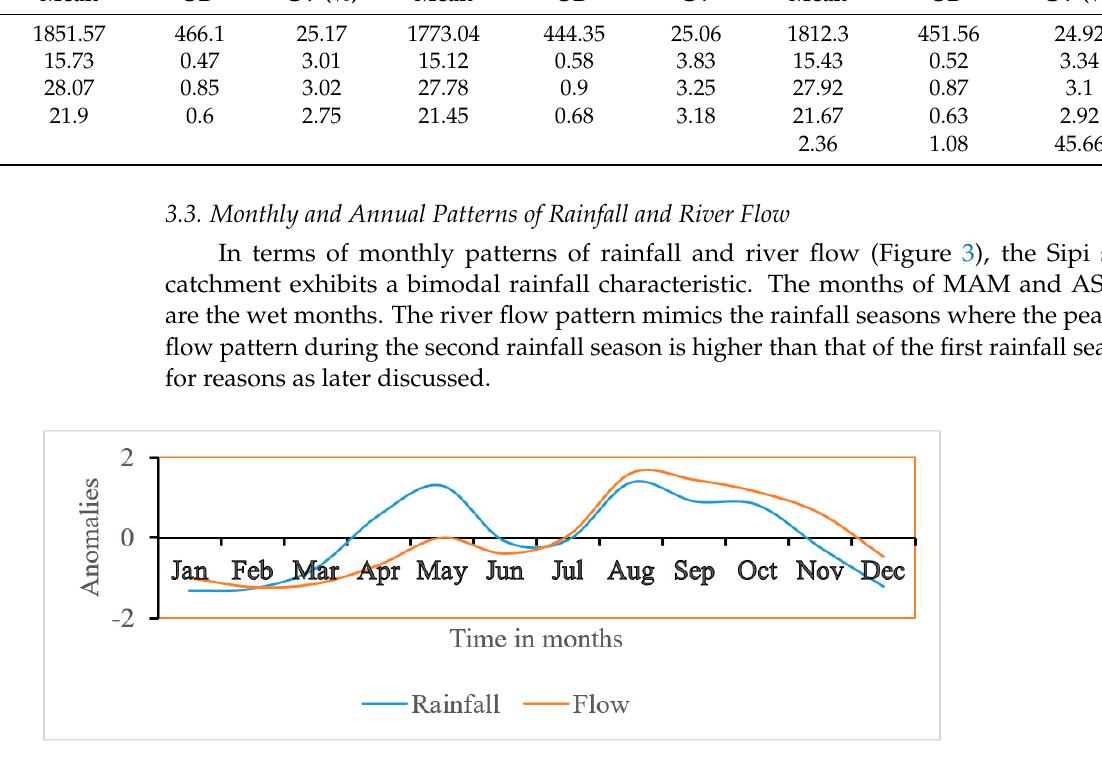
Figure 3. Monthly patterns of mean rainfall and flow in Sipi sub-catchment (1998–2015).